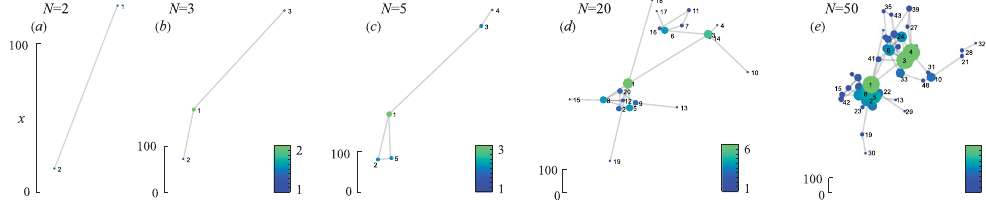
Figure 2. Schematic illustration of the network generation algorithm. Visualizations of the network are given at different stages of the growth (i.e. different number of attached nodes): ( a ) n = 2, ( b ) n = 3, ( c ) n = 5, ( d ) n = 20, ( e ) n = 50. For comparison, the spatial scale is given on each figure. The color of the node (together with its size) denotes its degree (see legends). Once again, the control parameters are λ = 0.02 and β =